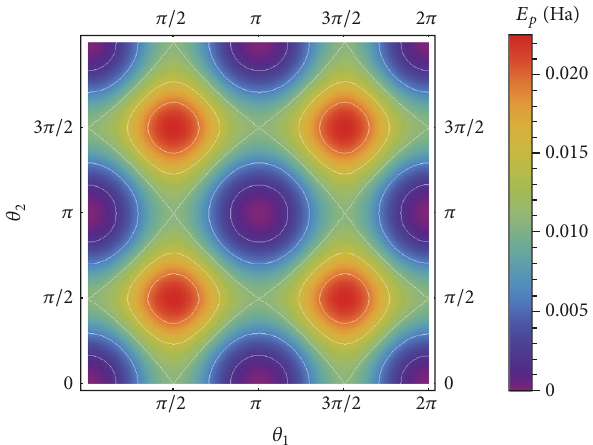
Figure 3: Torsional PES of paradinitrobenzene. The conformational energies (in Hartree) of the minima are zero, while the barriers around ( 0, 𝜋/2 ) are 0.0107 Ha and 0.0225 Ha at ( 𝜋/2, 𝜋/2 ).